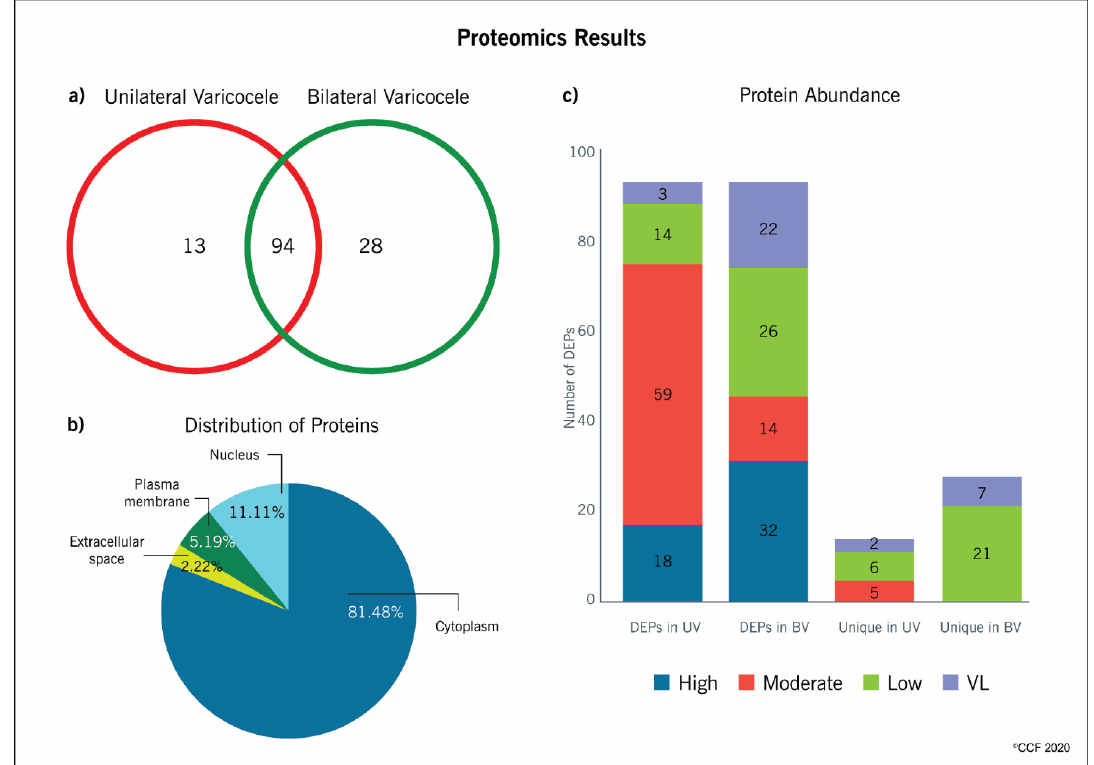
Figure 1. ( a ) Di ff erential expression proteins predicted to be acetylated in unilateral and bilateral varicocele, ( b ) Abundance of di ff erentially expressed proteins, ( c ) Distribution pattern of di ff erentially expressed proteins involved in the acetylation process.